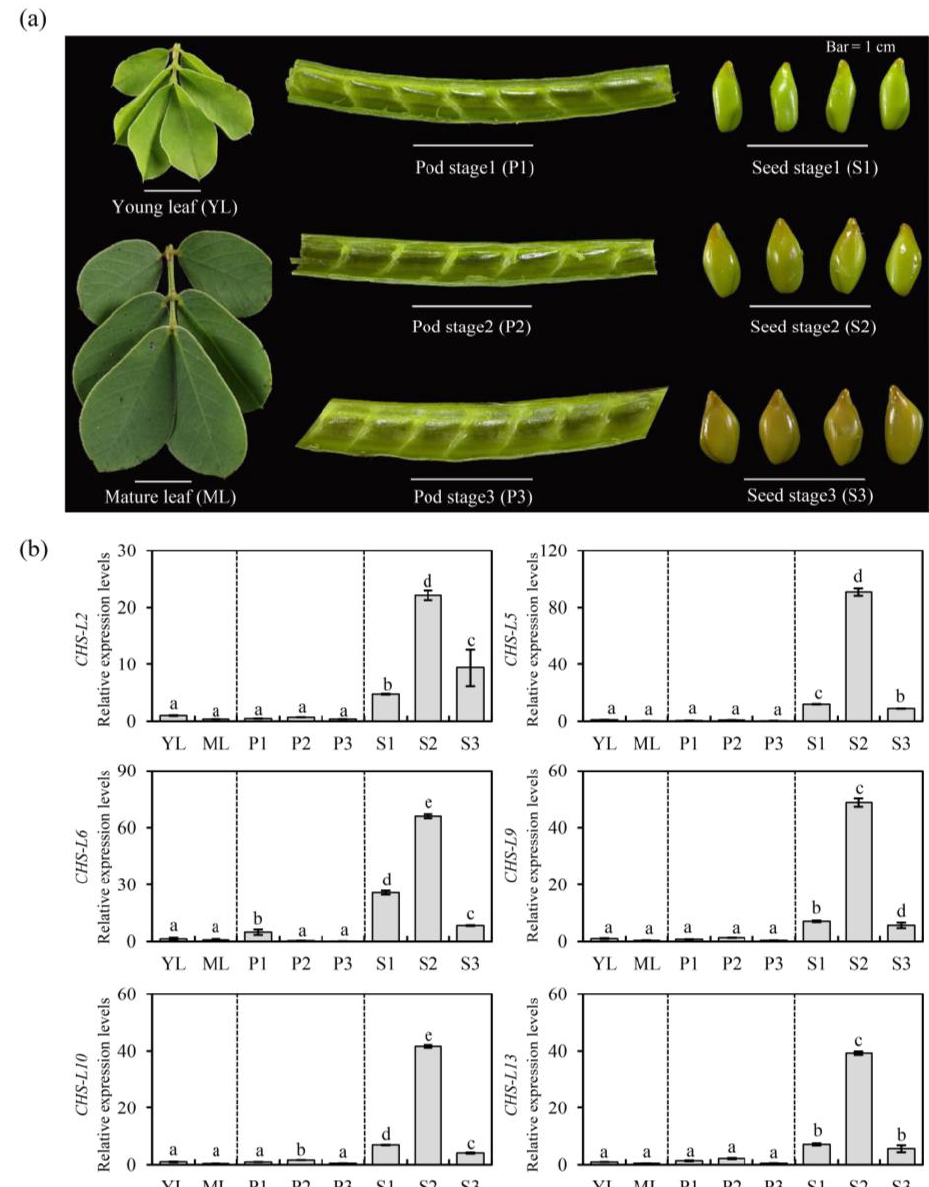
Figure 6. The expression patterns of six CHS-L genes in different Senna tora tissues. ( a ) The morphol- ogy of the leaves, pods, and seeds. Bars = 1 cm. ( b ) The relative expression levels of the six CHS-L genes were determined by quantitative real-time PCR (qRT-PCR). Each bar represents the means of three independent biological replicates with the standard error. Different letters demonstrate significant differences among the different tissues ( p <